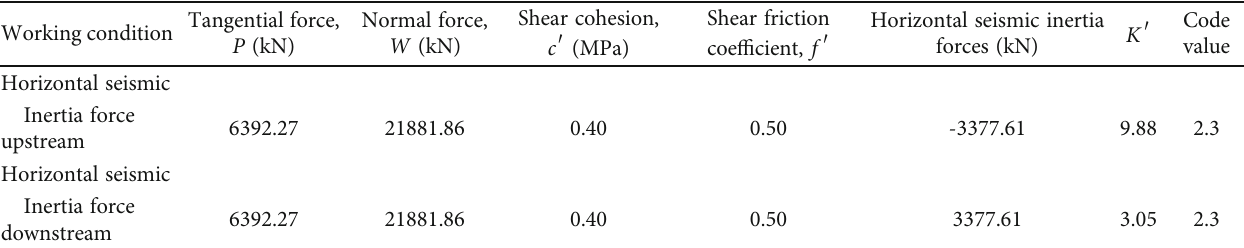
Table 3: Calculation and analysis table of antisliding stability of foundation surface of retaining dam section under static and dynamic superposition.